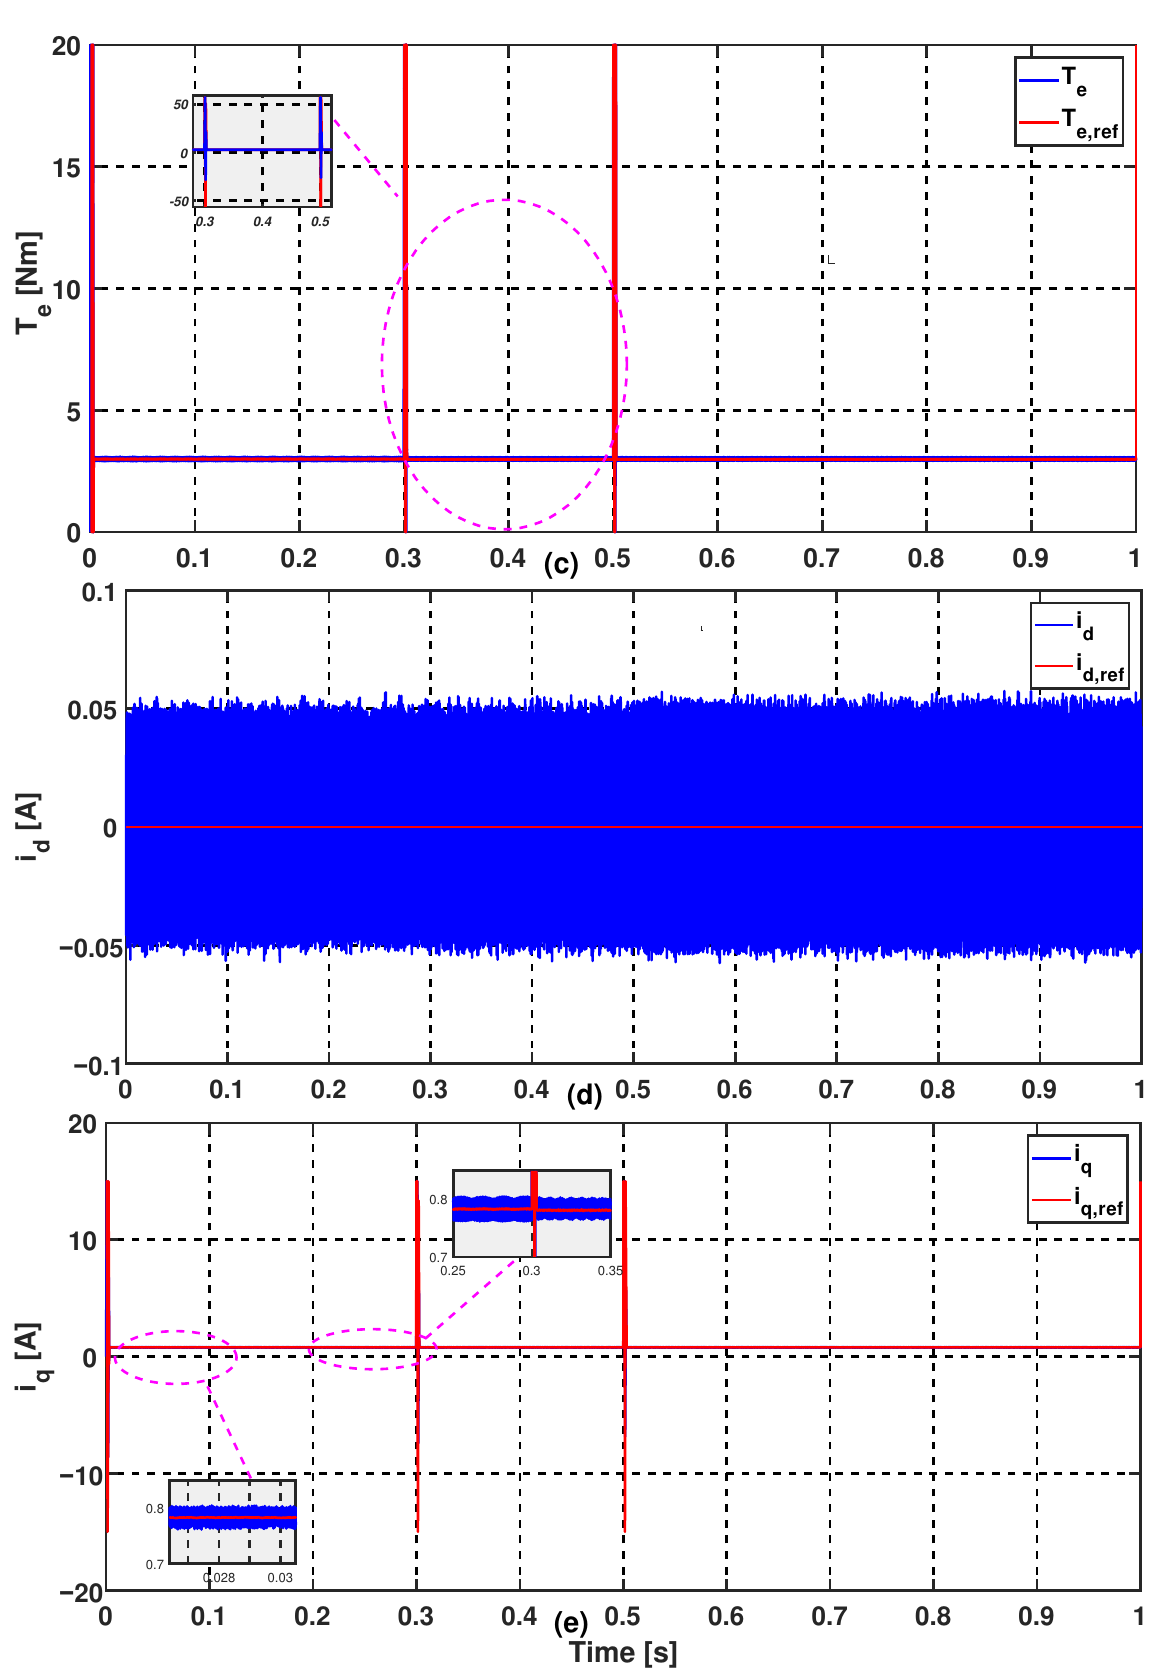
Figure 8. Performances of the traditional FCS-MPC applied on PMSM drive system (from top): ( a ) Speed ( ω m , ω m , ref ), ( b ) tracking error ( ∆ ω m ), ( c ) electromagnetic torque ( T e , T e , ref ), ( d ) direct current ( I d , I d , ref ), and ( e ) quadratic current ( I q , I q , ref